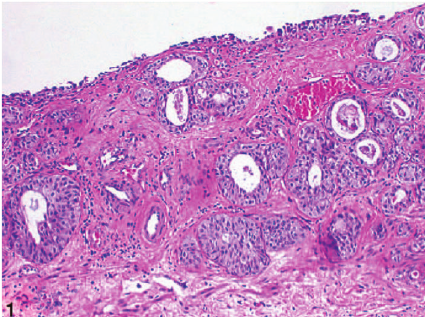
Figure 2: Low-power view showing bland tumor cells in the nested pattern infiltrating the muscularis propria (hematoxylin- eosin, original magnification × 100). Nested variant of urothelial carcinoma taken from Dhall et al. [2]. The figures have been reproduced with the permission of the editor in chief of Archives of Pathology and Laboratory Medicine on behalf of the editorial board of the